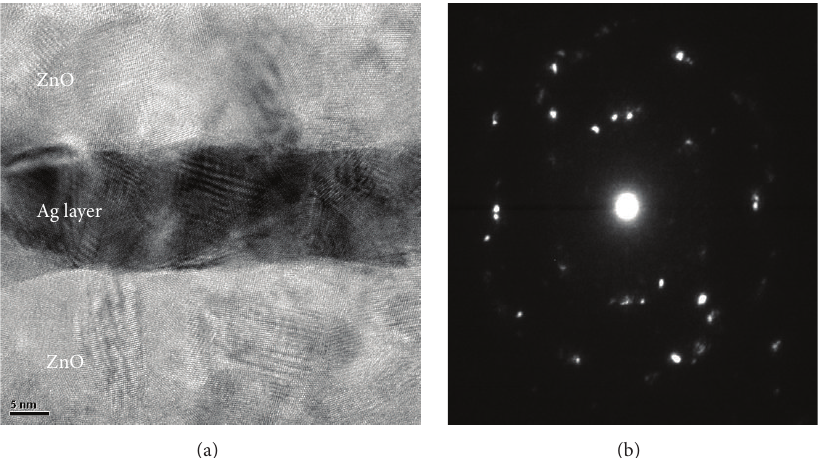
Figure 6: (a) Cross-sectional TEM images of the ZA(10)Z stacked layer and (b) the diffraction pattern of ZnO in ZAZ stacking layer.